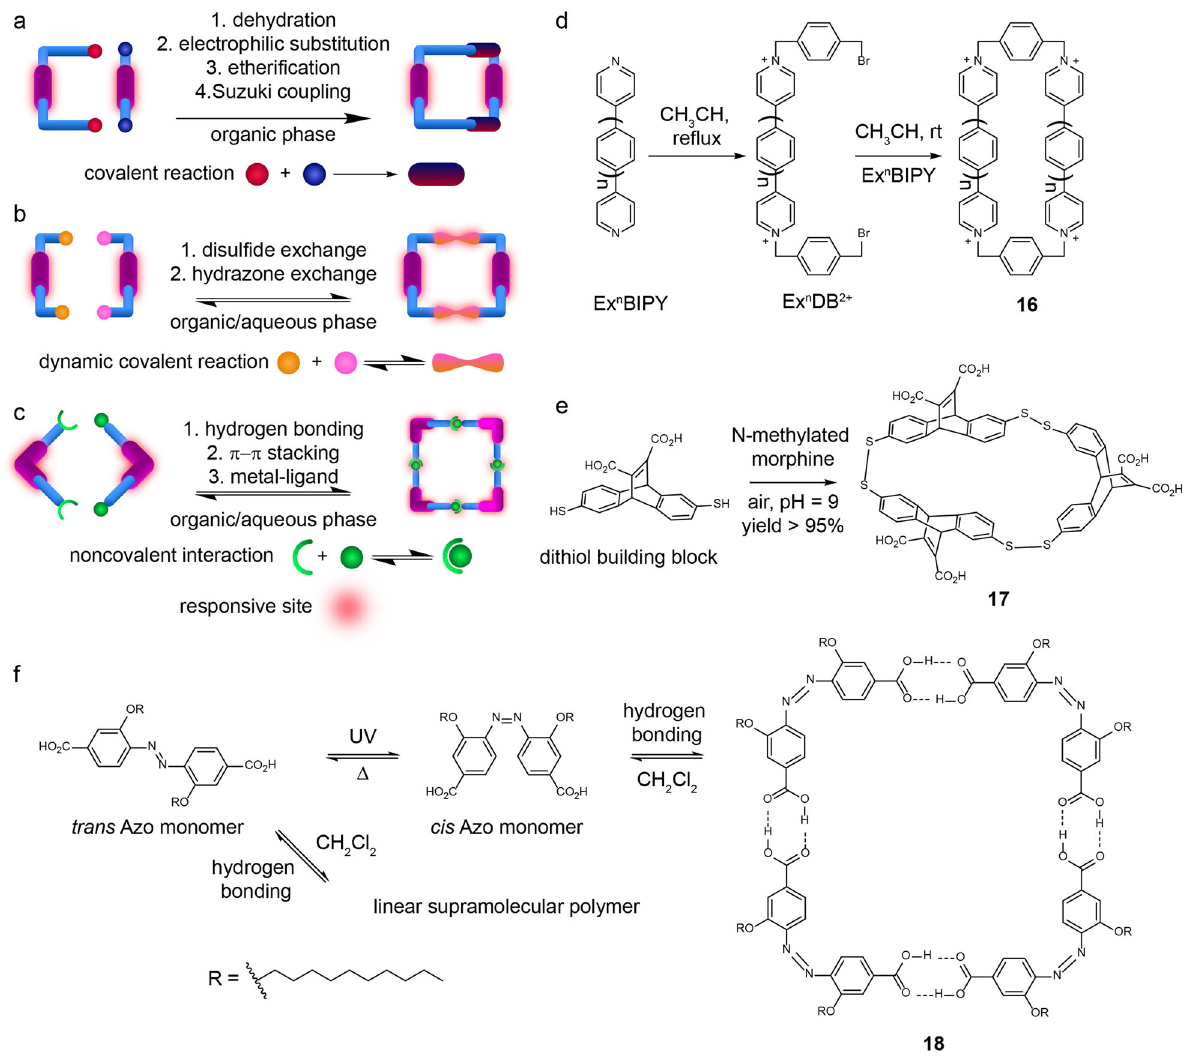
Fig. 5 The schematic representation of ring-closure methods for RMs. the RMs are synthesized by a covalent ring-closure strategy mainly including dehydration, electrophilic substitution, etheri fi cation and Suzuki coupling reaction in organic phase, b dynamic covalent ring-closure strategy mainly including disul fi de and hydrazine exchange and c noncovalent ring-closure strategy mainly including hydrogen binding, π – π stacking and metal-ligand interactions. The synthetic route of d macrocycle 16 using the covalent ring-closure strategy 39,49 , e macrocycle 17 using the dynamic covalent ring-closure strategy 55 and f macrocycle 18 using the noncovalent ring-closure strategy 61